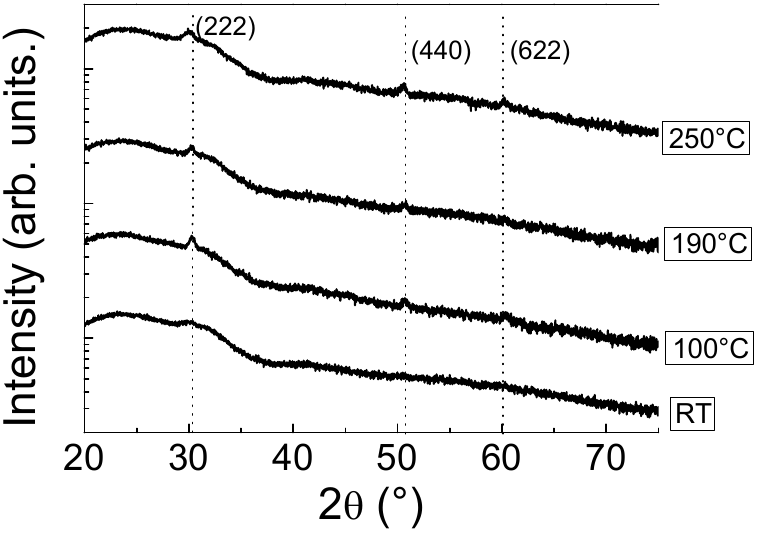
Figure 4. GI ‐ XRD scans of 45 nm ‐ thick ITO thin films as function of the substrate temperature.